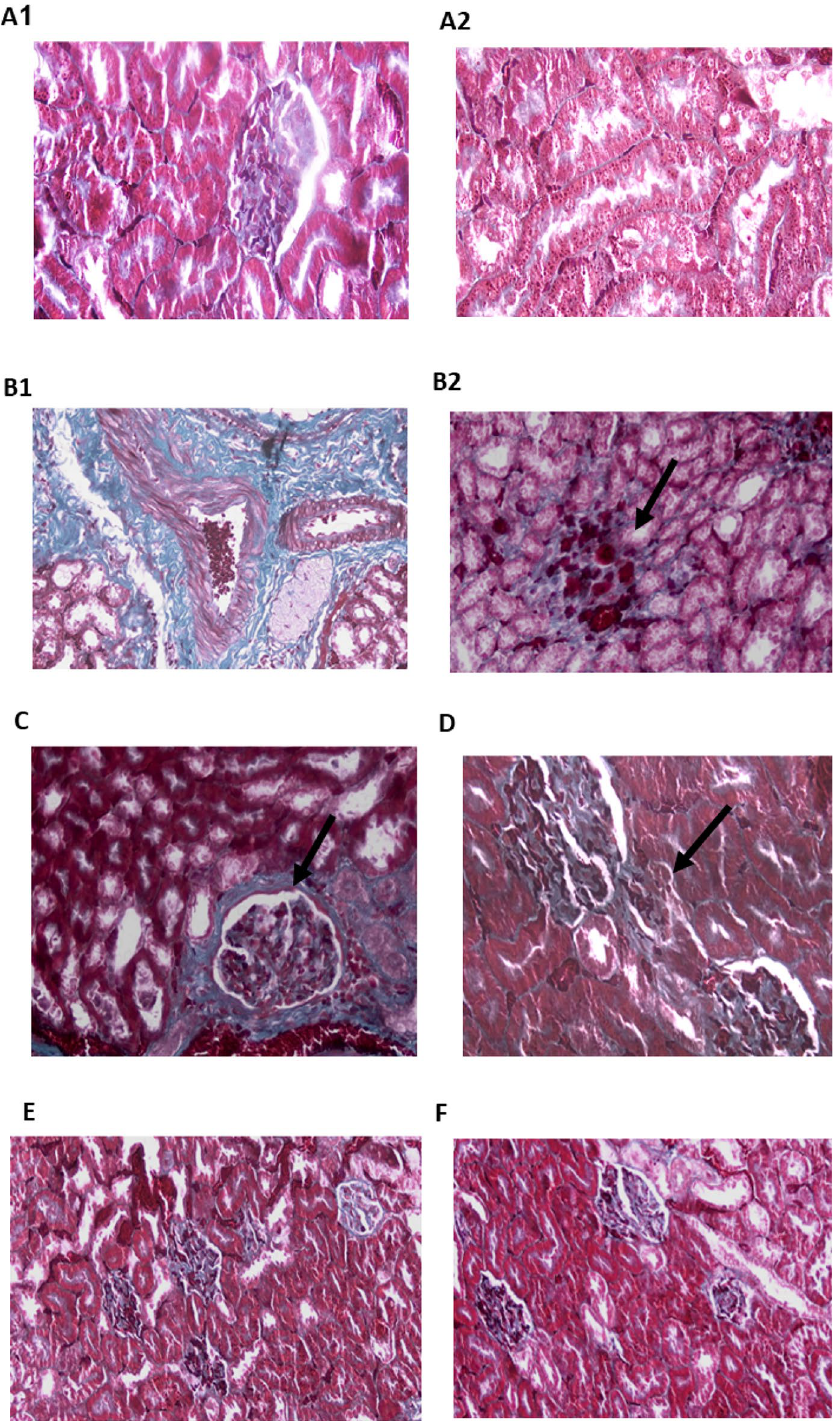
Figure 6. Photomicrograph of kidney tissue sections in different studied groups using Masson’s trichrome staining. ( A ) Control group; ( B1,B2 ) model group (dexamethasone-treated group) showing diverse array of pathological features, ranging from stromal interstitial fibrosis surrounding tubules and glomeruli ( B1 , ×400) to fibrotic glomeruli with remnants of glomerular capillaries (arrow) ( B2 ; ×400); ( C ) PRV 0.5 mg/kg slight decrease of fibrosis with remnants around the glomeruli remained (arrow); ( D ) PRV 1 mg/kg showing less interstitial fibrosis (arrow) between the glomeruli and a better histopathological pattern ( D , ×400); ( E ) PRV 2 mg/kg; ( F ) losartan-treated group. Both PRV2 mg/kg and losartan treated groups reversed dexamethasone- induced fibrosis with normal glomeruli and tubules as well as some degree of hypercellular glomeruli and occasional shrinking glomeruli in the losartan-treated